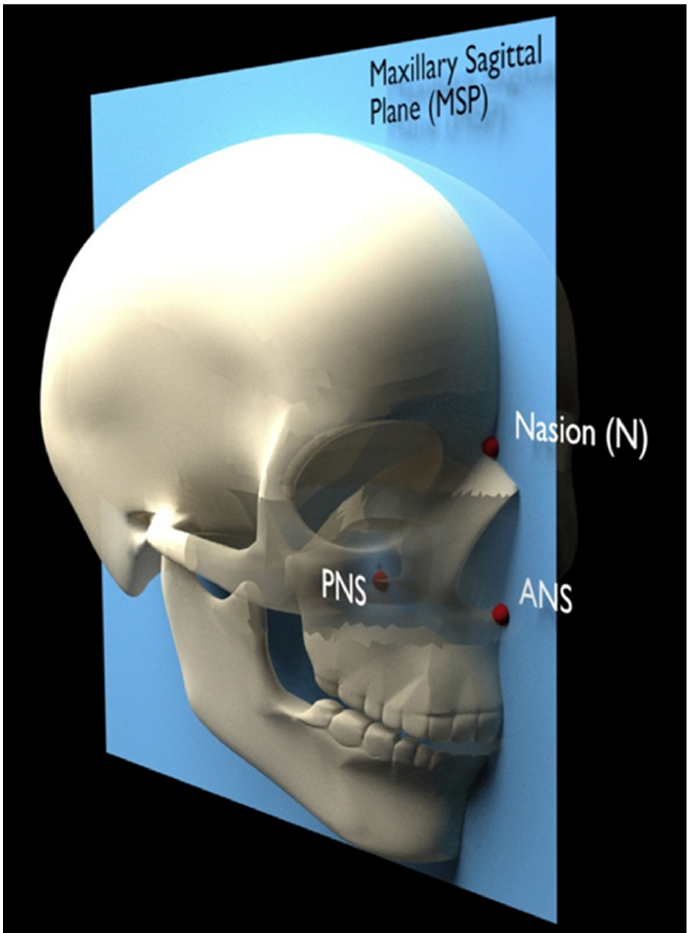
Figure 2. Three-dimensional visualization of the midsagittal plane passing through ANS, PNS and Nasion.